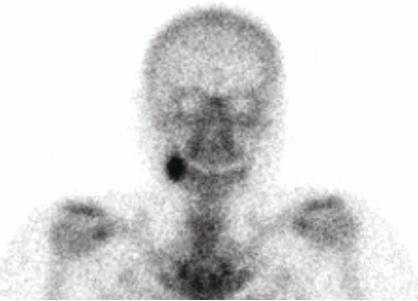
Figure 5: Bone scintigraphic fi ndings obtained during the initial visit. Bone scintigraphy shows a strong accumulation of technetium medronic acid (99mTc-MDP) in the right mandibular ramus.